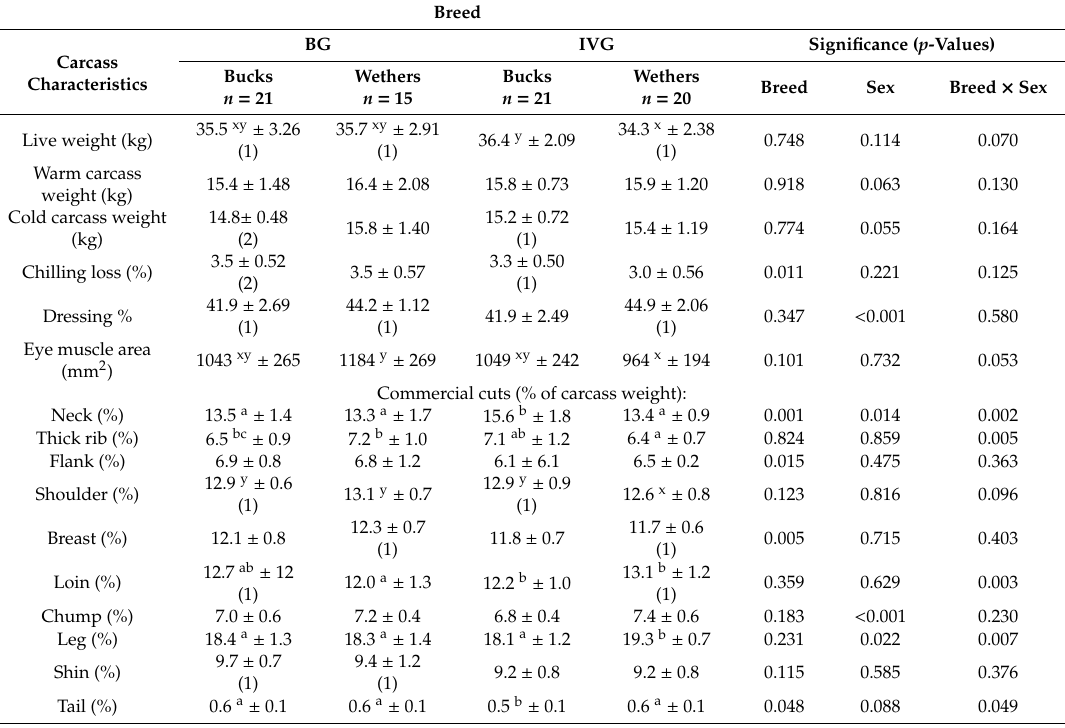
Table 1. Least-square means and standard error (SE) of means for carcass characteristics of Boer and large frame Indigenous Veld buck and wether goats (number of outliers removed indicated in